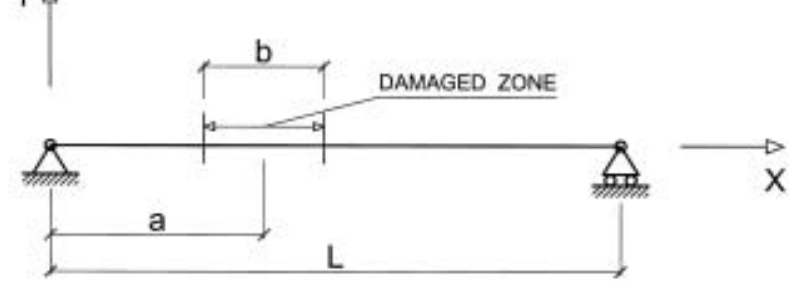
Fig. 1. Sketch of the model of the simple